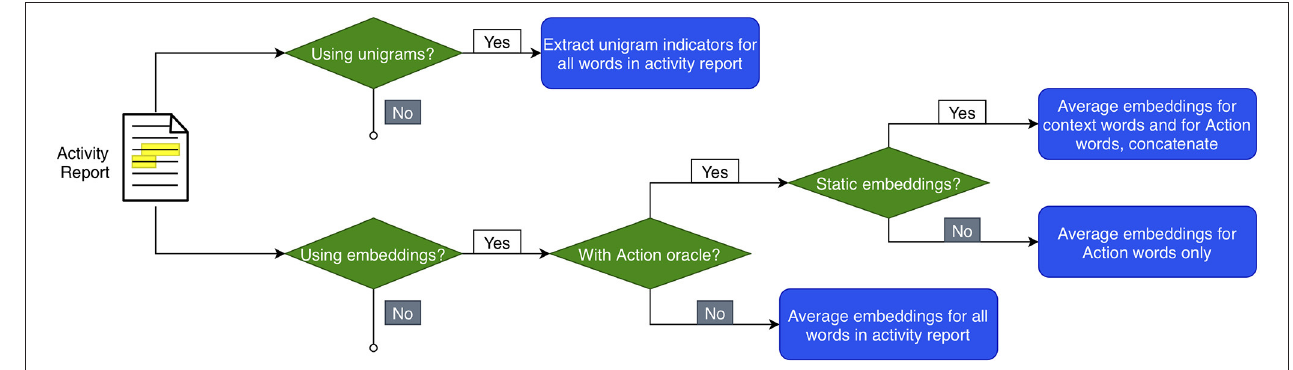
FIGURE 2 | Experimental settings for representing activity reports for machine learning models. Unigram and embedding features were used both separately and together.